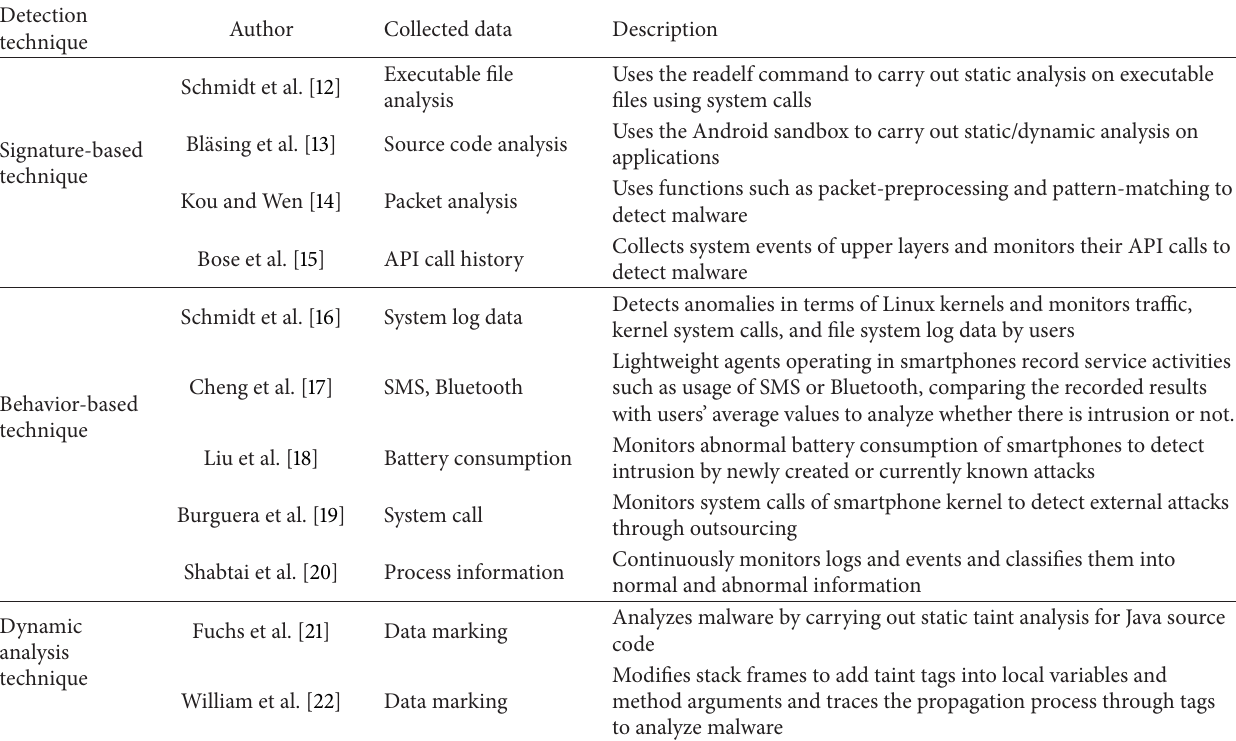
Table 1: Trends of studies on mobile malware detection